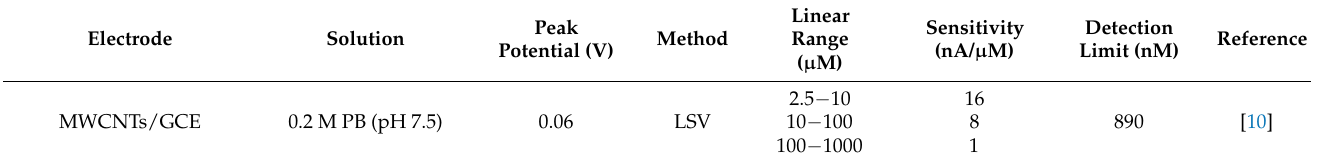
Table 1. Comparison of the performances of different electrochemical sensor for HcySH.